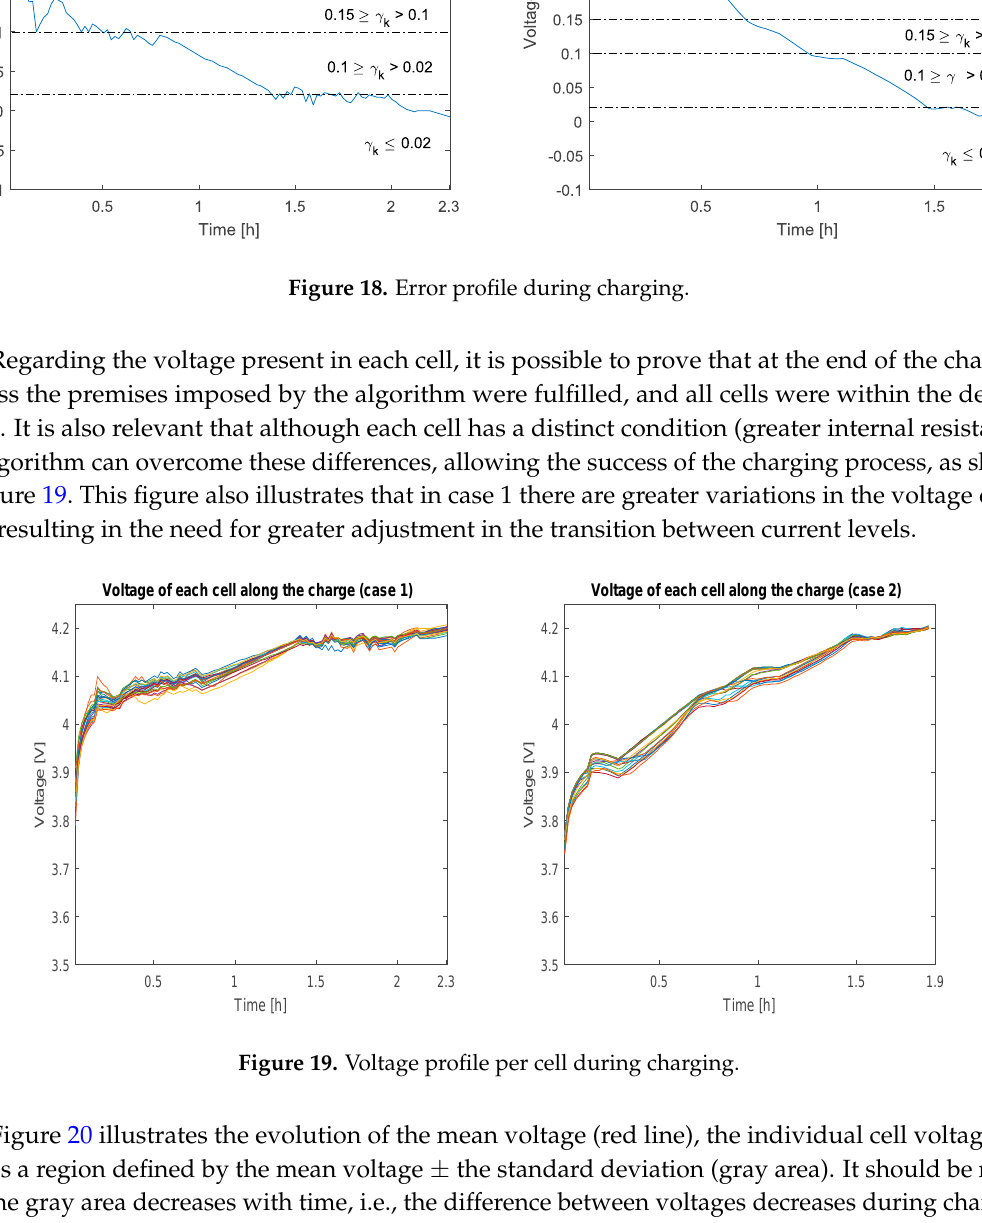
Figure 20. Voltage profile per cell vs. stopping criterion. The red line represents mean voltage, the gray area represents the mean of the voltages ± the standard deviation.